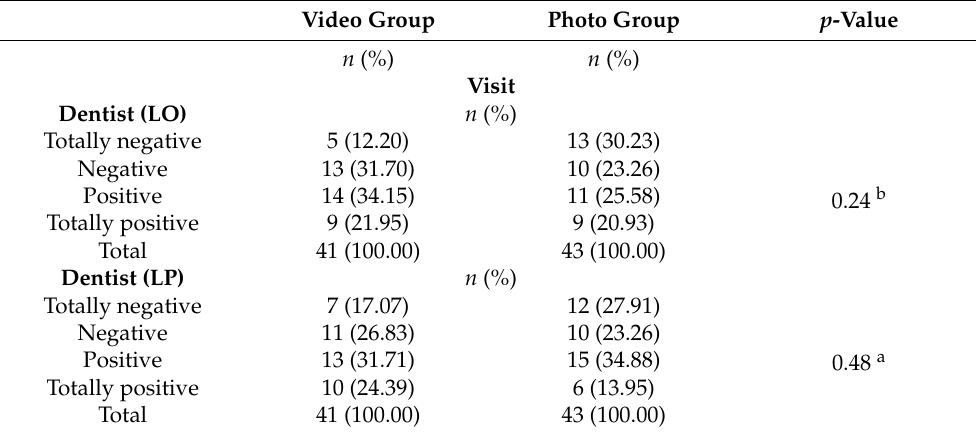
Table 6. Collaboration scores according to the Frankl Behavioral Scale in both groups expressed by the two dentists (LO and LP) who performed the oral examination. Video